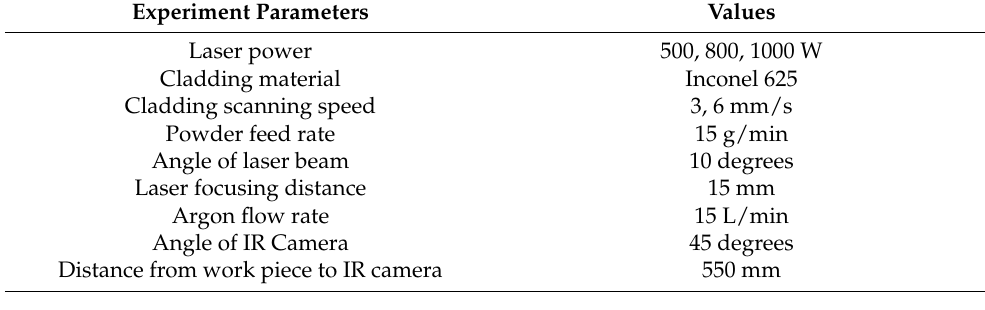
Table 1. Laser-cladding process parameters.